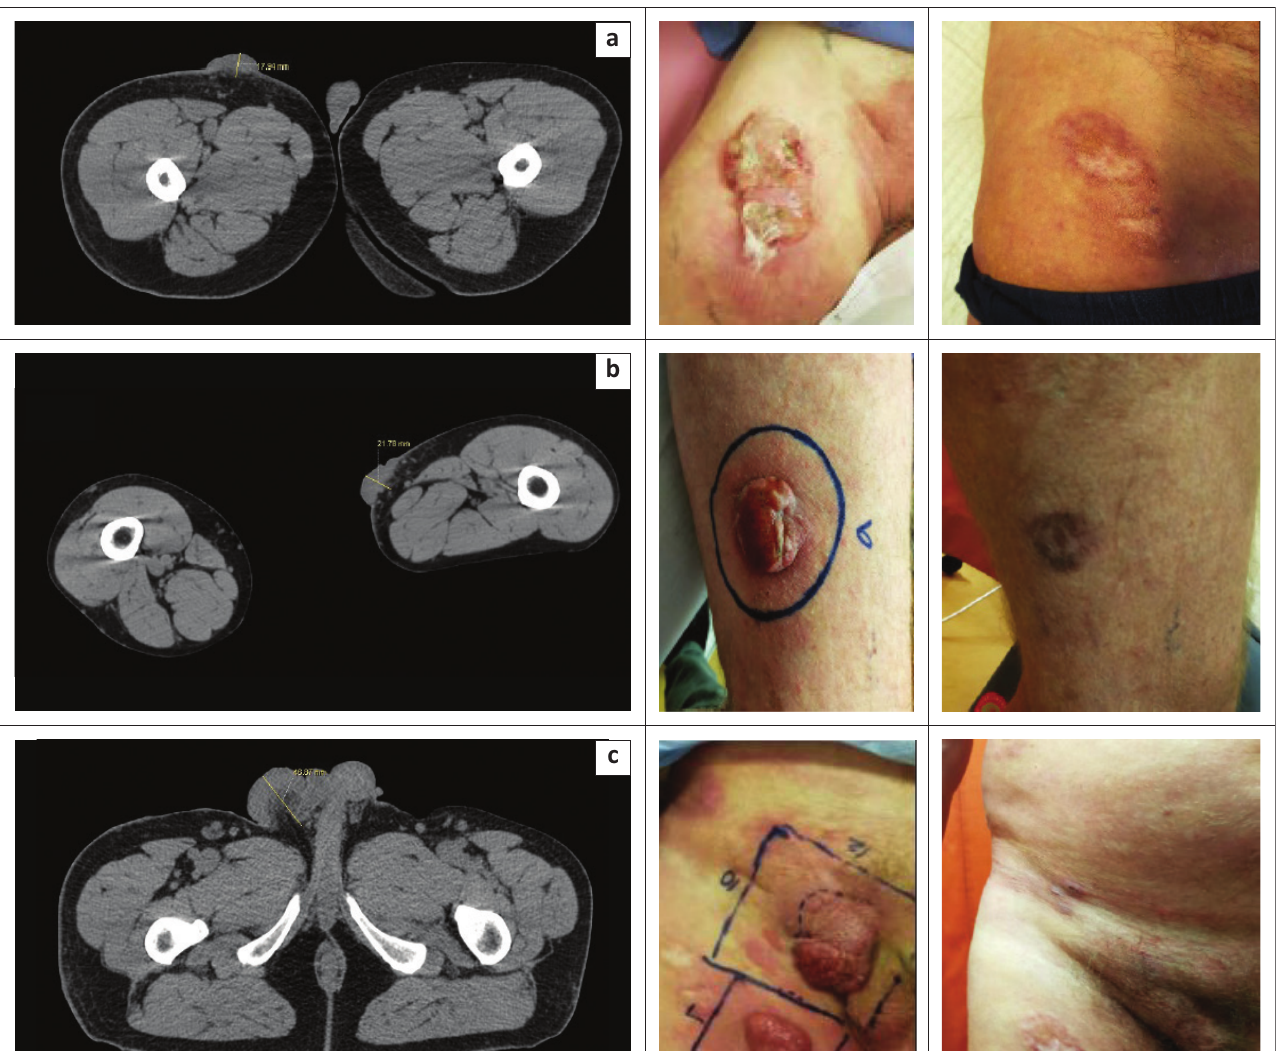
FIGURE 1: Computed tomography planning, preradiotherapy and postradiotherapy mycosis fungoides lesions (a) (right anterior thigh), (b) (medial left thigh), (c) (right